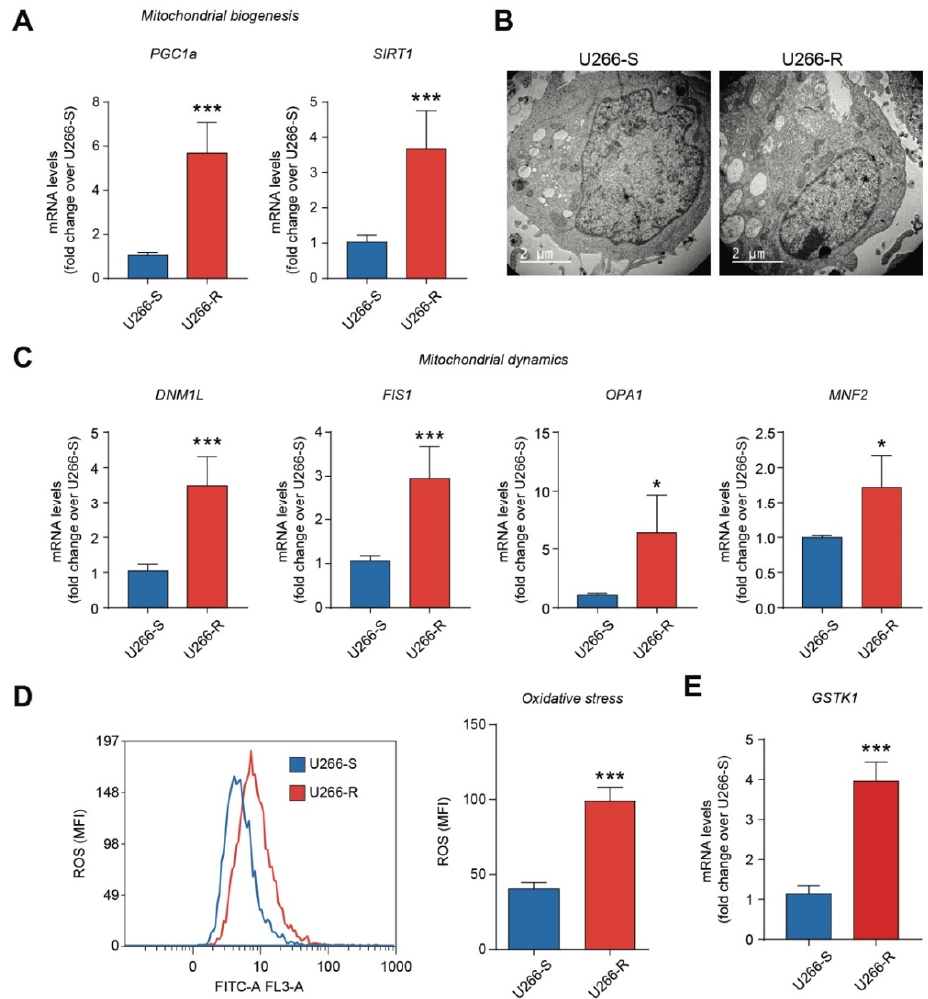
Figure 1. Mitochondrial biogenesis, mitochondrial dynamics and the antioxidant system are increased in U266-R. ( A ) Mitochondrial biogenesis analysis of mRNA levels of PGC1α and Sirtuin 1 (SIRT1) in U266-S versus U266-R cell lines; data are fold changes over U266-S and expressed as mean ± SEM of n ≥ 3 biological replicates; *** p -value < 0.001 versus U266-S. ( B ) Representative transmission electron microscopy (TEM) pictures of ultrathin sections showing mitochondrial contents of U266-S and U266-R cells. ( C ) Mitochondrial dynamics analysis of mRNA levels of DNM1L, FIS1, OPA1 and MNF2 in U266-S versus U266-R cell lines; data are fold changes over U266-S and expressed as mean ± SEM of n ≥ 3 biological replicates; * p -value < 0.05 and *** p -value < 0.001 versus U266-S. ( D ) Reactive oxygen species production during drug treatment was measured by the oxidation of 2′,7′-dichlorofluorescein (DCF) using flow cytometry. Representative plot and quantification of cytofluorimetric analysis in U266-S and U266-R cell lines; data are expressed as mean MFI ± SEM of n ≥ 3 biological replicates; *** p -value < 0.001 versus U266-S. ( E ) mRNA levels of GSTK1 in U266-S versus U266-R cell lines; data are fold change over U266-S and expressed as mean ± SEM of n ≥ 3 biological replicates; *** p -value < 0.001 versus U266-S. MFI: mean fluorescence intensity.